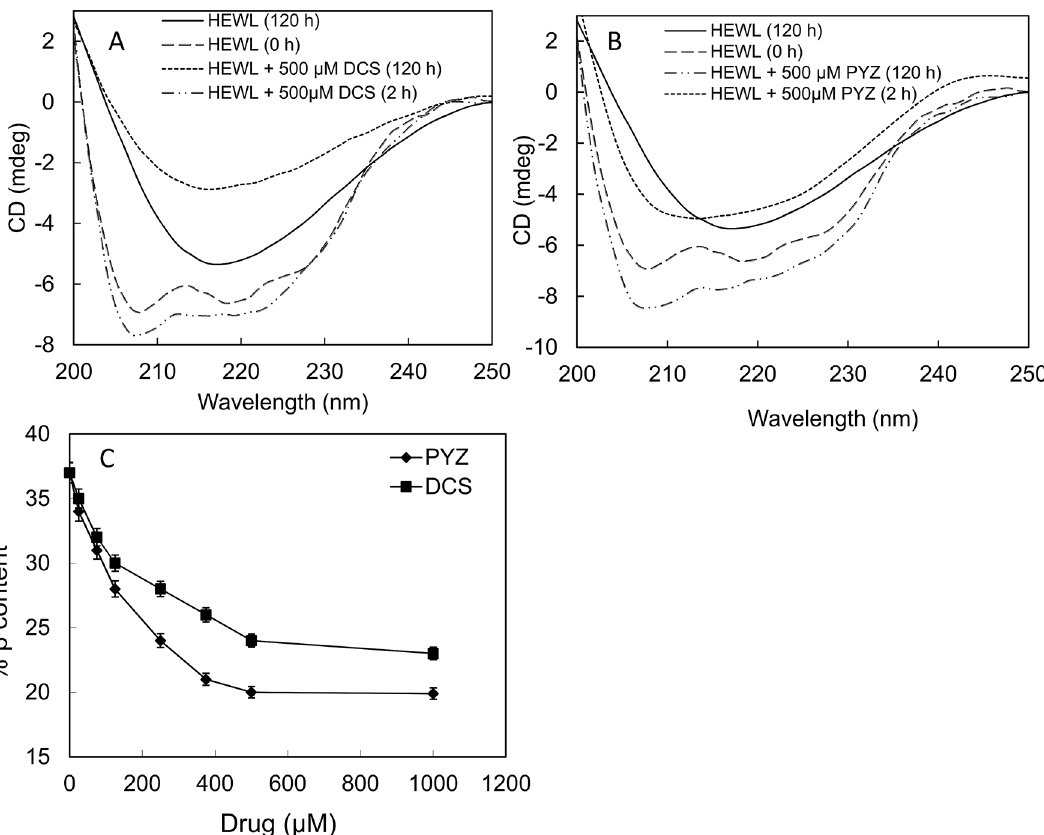
Fig 5. Far-UV CD measurements. (A) Far-UV CD spectra of HEWL incubated at 65°C for different time intervals in absence and presence of DCS (500 μ M) (B) Far-UV CD spectra of HEWL incubated at 65°C for different time intervals in absence and presence of PYZ (500 μ M). (C) Percent β structure profile of HEWL incubated at 65°C over 120 h with varying concentration of DCS and PYZ (0 – 1000 μ M).